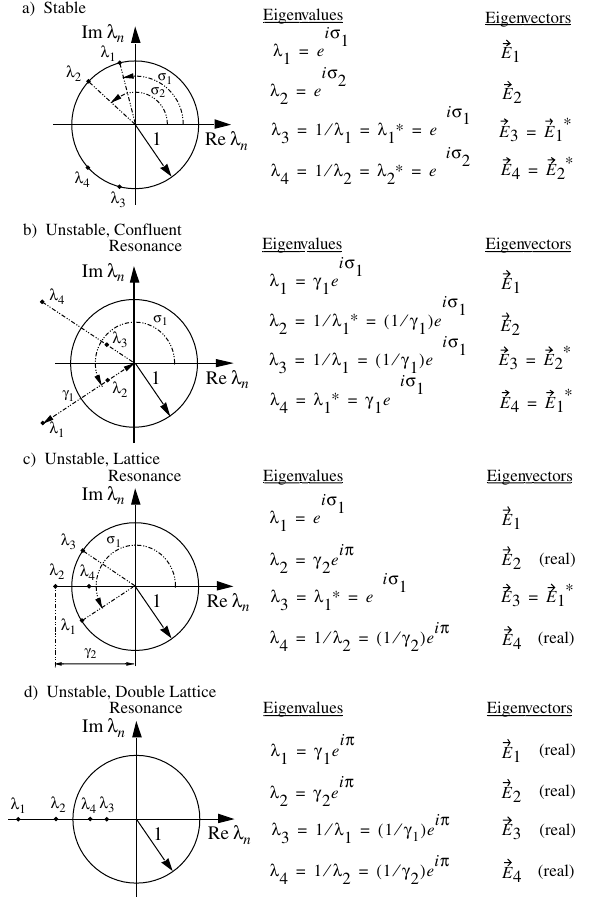
FIG. 4. Four possible classes of symmetries for the